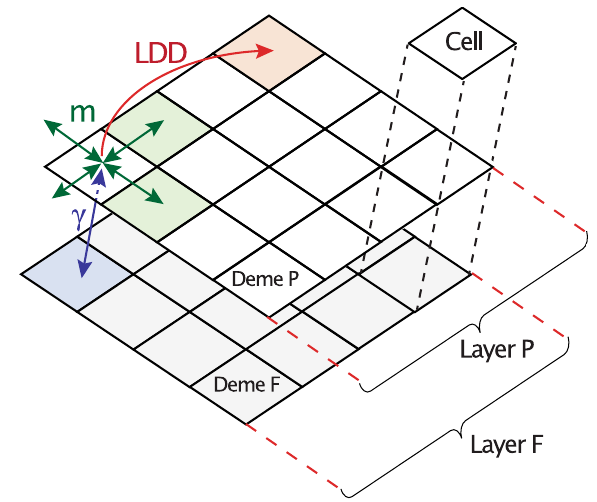
Fig. 3 Schematic representation of the modeling framework. Explanation about the computation of the various parameters presented in this fi gure are given in the Methods